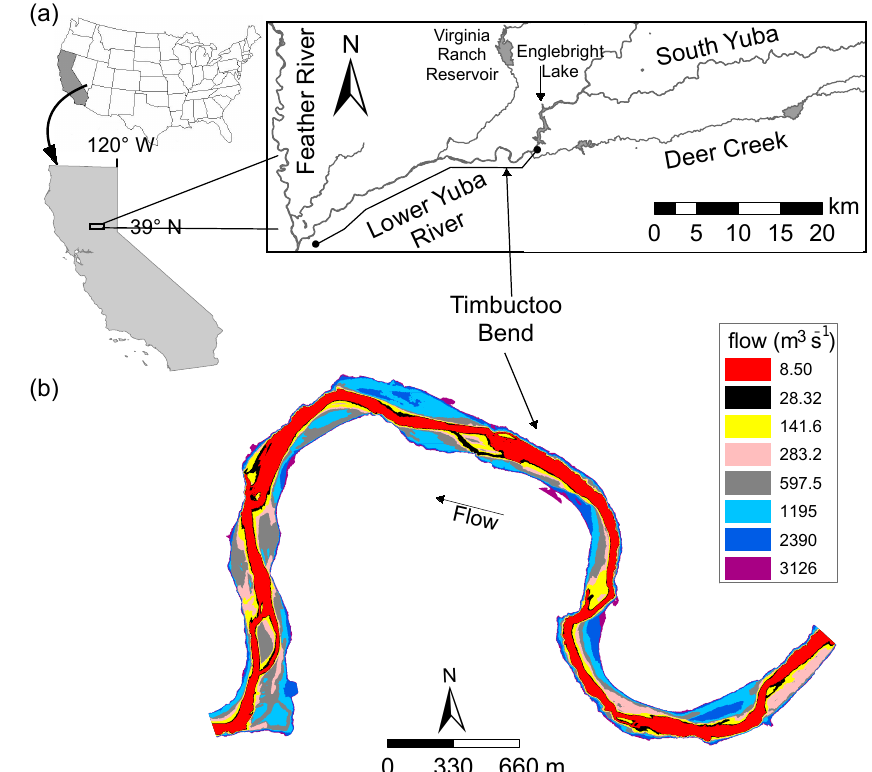
Figure 1. Regional and vicinity map of the lower Yuba River (a) and extent of study segment showing inundation extents predicted by the 2-D model (b)